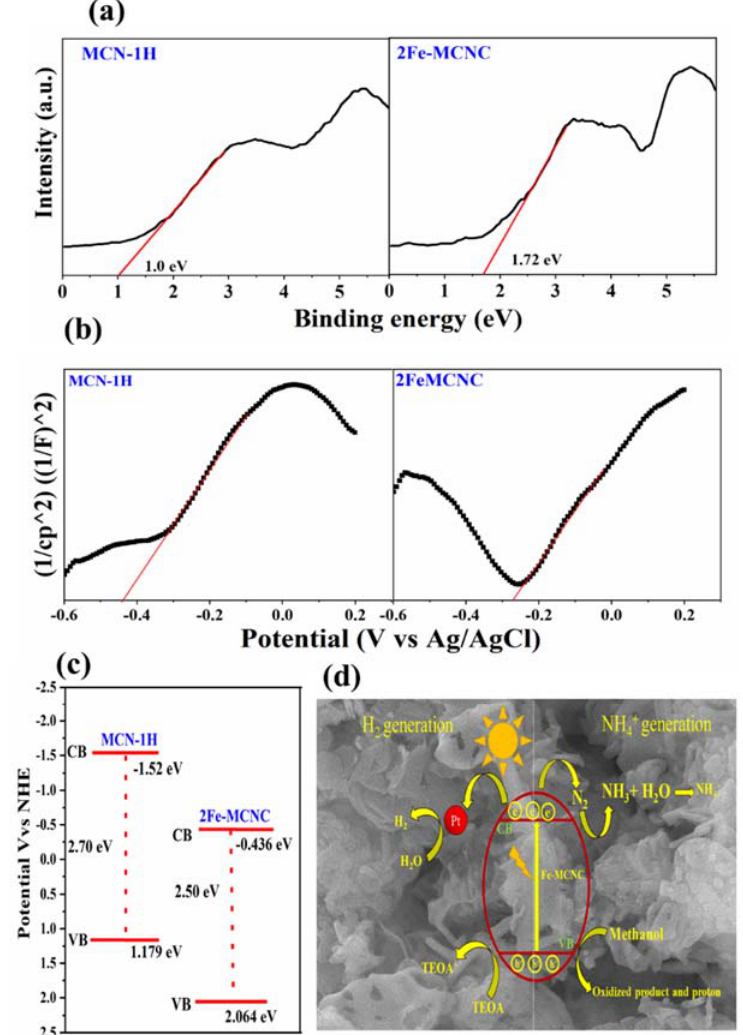
Figure 11. ( a ) VB XPS spectra and ( b ) the Mott–Schottky plots of MCN-1H and 2Fe-MCNC ( c ) The band structure of MCN-1H and 2Fe-MCNC; ( d ) the possible photocatalytic hydrogen generation and N 2 fixation mechanism for the Fe-MCNC nanostructure.